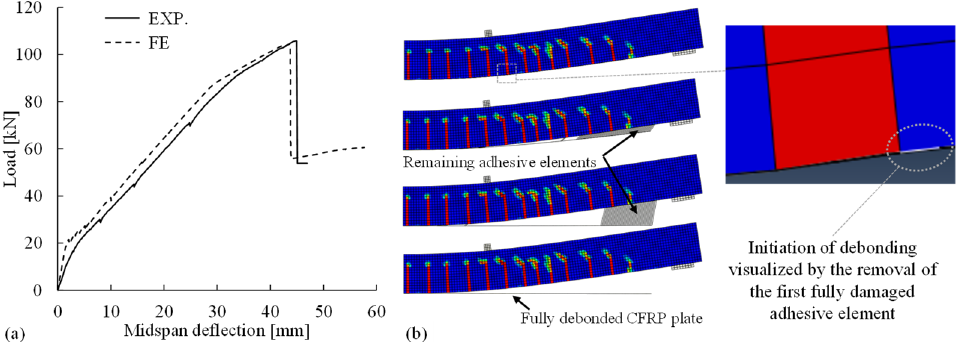
Figure 21. ( a ) Comparison of the flexural responses between experimental measurements (EXP) and numerical results (FE) and ( b ) intermediate cracks (IC) debonding of CFRP plate simulated in the FE analysis.